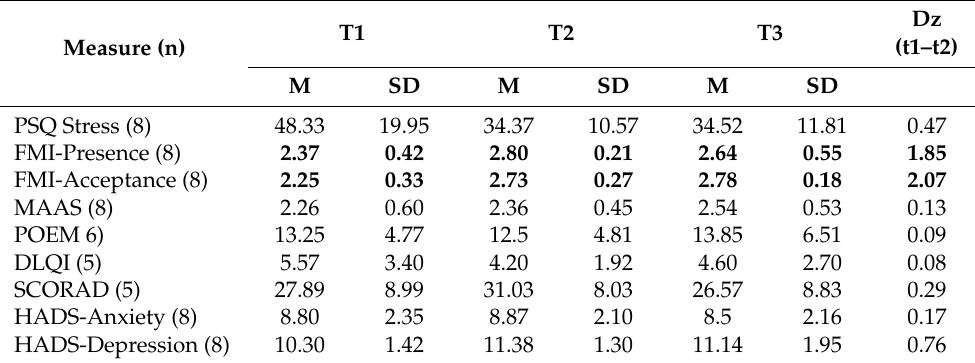
Table 2. Mean Scores at t1 (pre), t2 (post) and t (three months